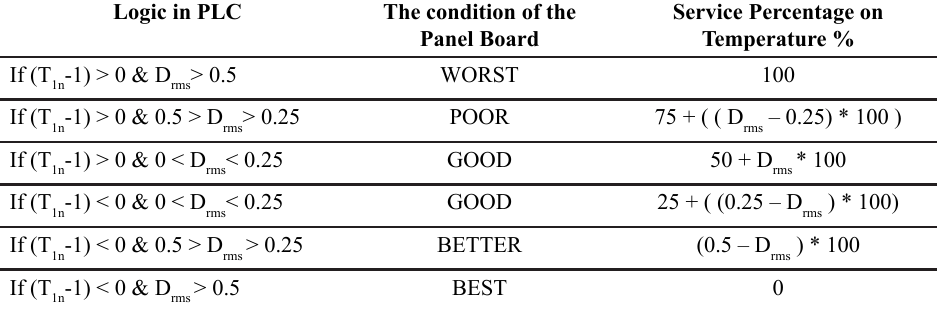
Table 6: PLC Logic for service condition on humidity. Logic in PLC The condition of the Panel